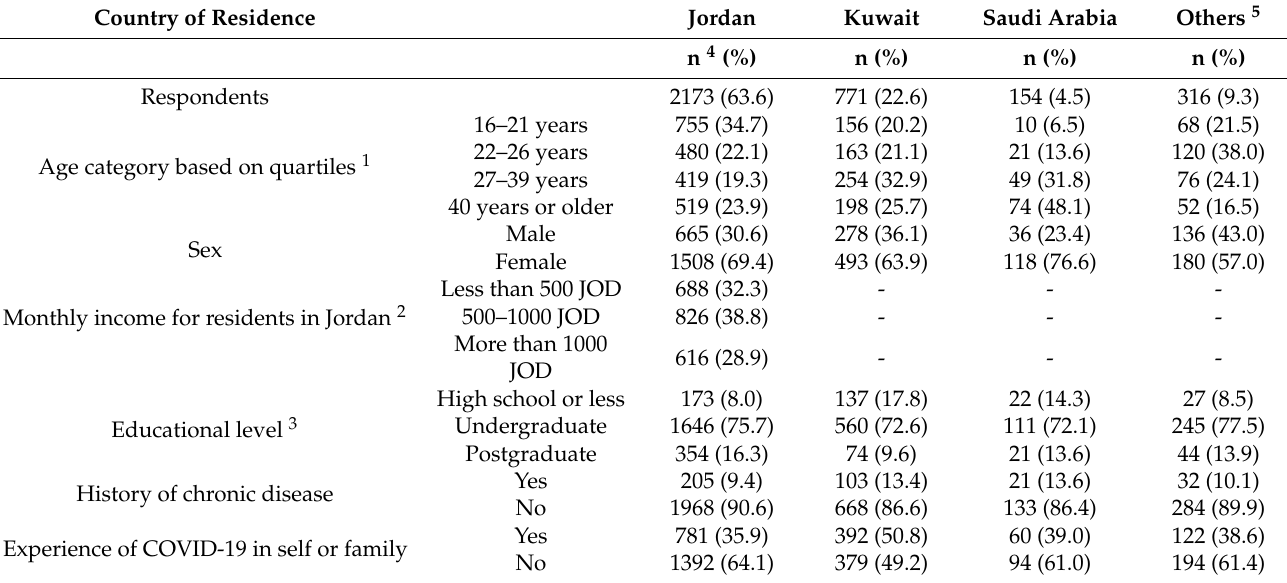
Table 1. Characteristics of the study sample stratified by country of residence. Country of